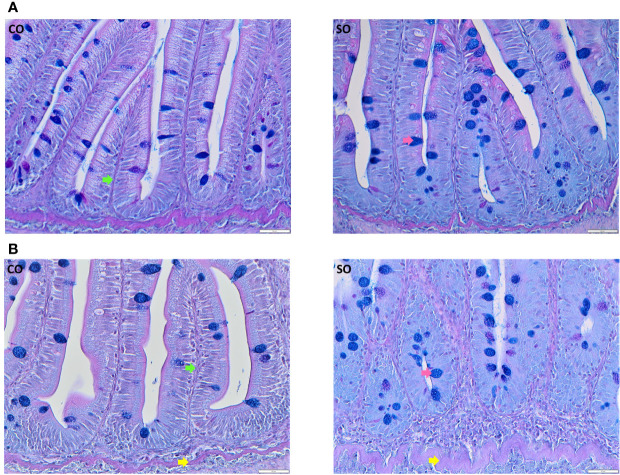
Photomicrographs of the distal intestine of Atlantic salmon from the CO and SO groups. (A) Inflammatory features are not visible in the SO group on day 4 after the start of the feeding trial. (B) Saponin-induced inflammatory characteristics are evident at day 36 of the trial. Control group—CO, and soy-derivatives fed group—SO. Pink arrow—goblet cells, green arrow: lamina propria, yellow arrow—stratum compactum. Scale bar: 50 µm.